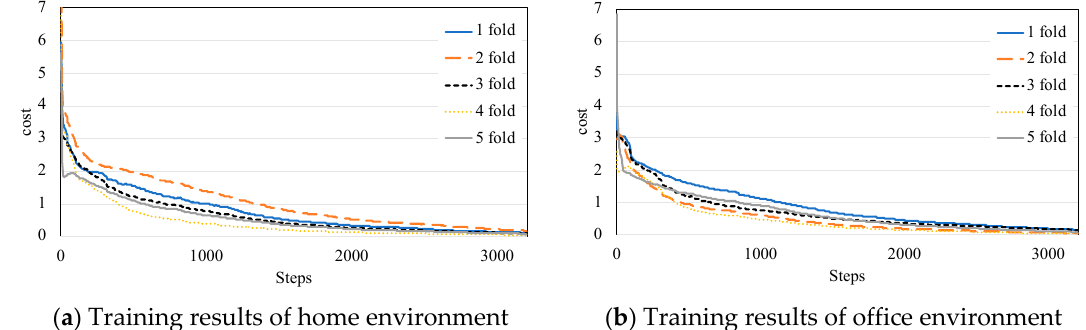
Figure 7. Training results of valid dataset.